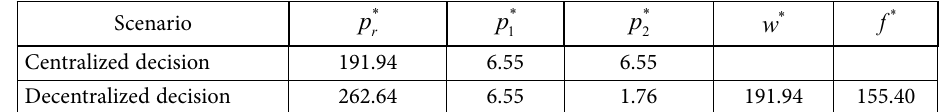
Table 3. Optimal values of the decision variables